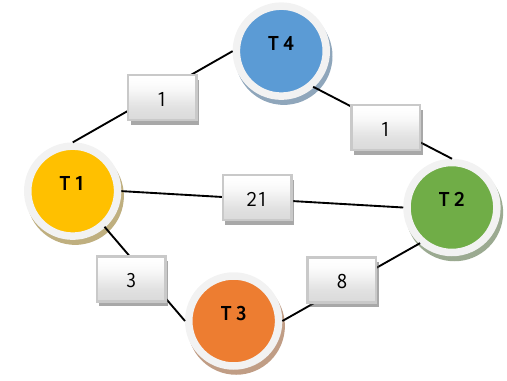
Table 5. Classification accuracy of nearest neighbour (%) 4.2 Nearest